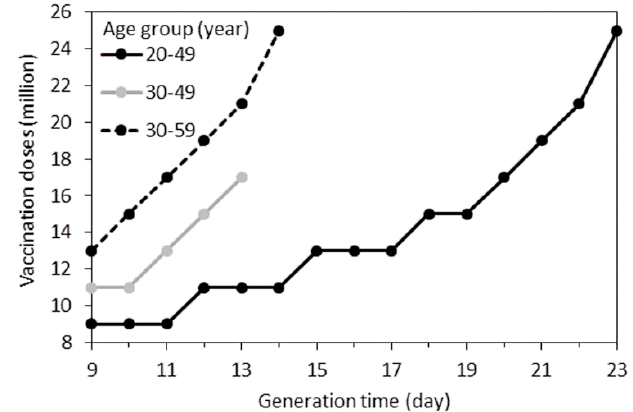
Figure 5. Sensitivity of the required minimum doses of vaccine to the mean generation time. SIP scenarios with an identical subject for vaccination are connected by lines. The minimum required doses are shown from 9 to 23 days of the mean generation time of rubella. Although we investigated mean generation times that varied from 9 to 27 days, the specified range from 9 to 23 days is shown, because R e was not expected to decrease to less than one by vaccinating the corresponding group.